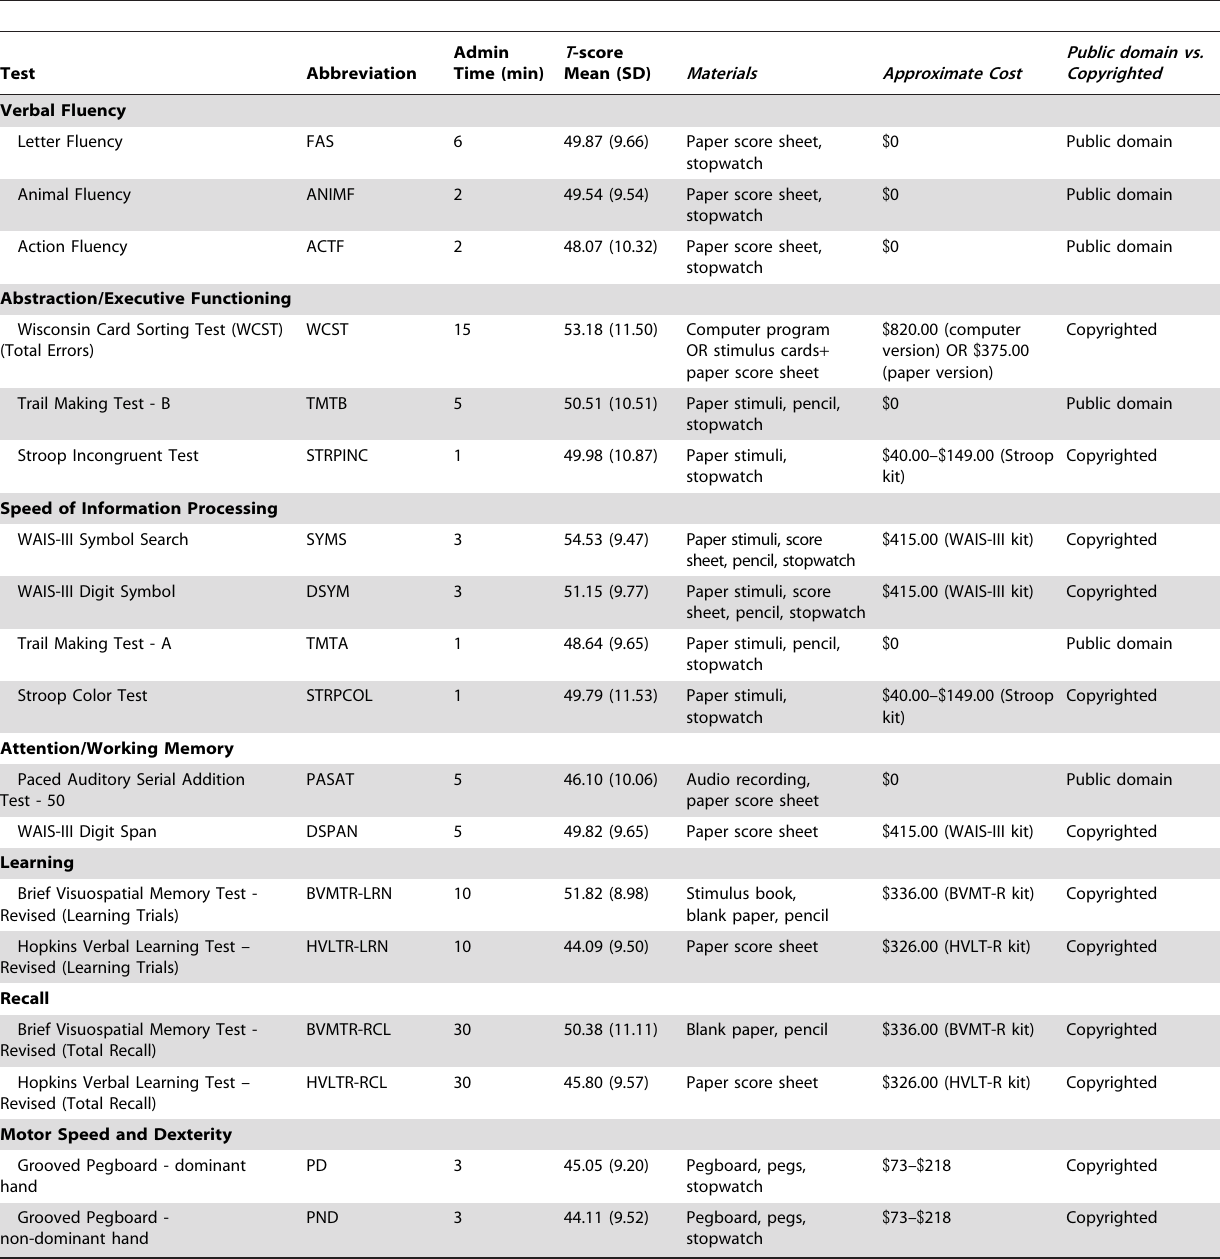
Table 1. Component tests from neuropsychological battery, abbreviations, estimated administration time, and mean (SD) T -score performance for each of the measures in our sample of 200 HIV-infected